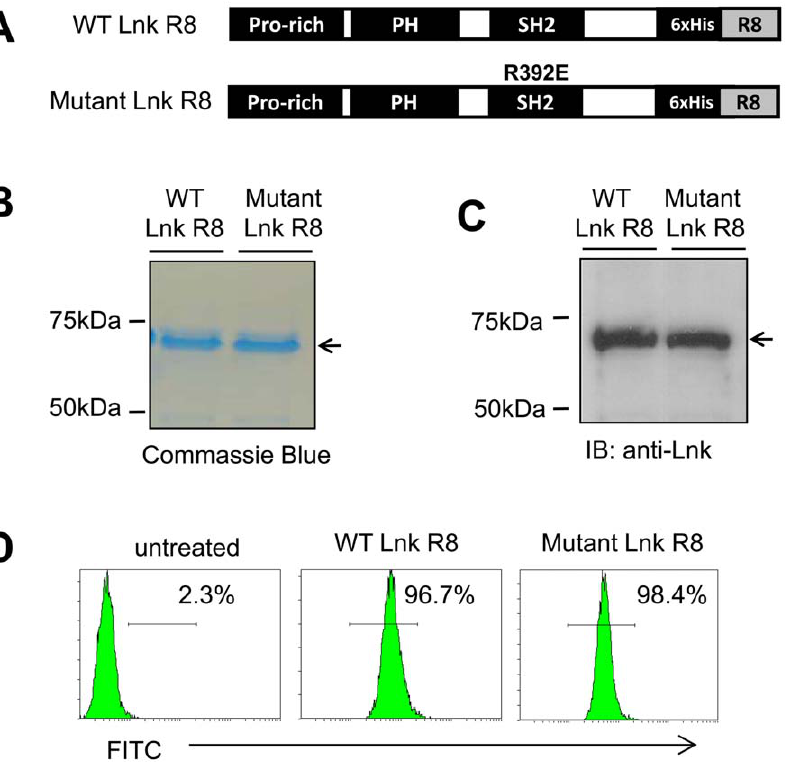
Figure 1. Efficient uptake of WT or mutant Lnk R8 fusion proteins. (A) Diagram of WT or mutant Lnk R8 constructs. Pro-rich:Proline-rich domain, PH:Pleckstrin homology domain, SH2:Src Homology 2 domain. (B) Coomassie blue staining of purified WT Lnk R8 or mutant Lnk R8. (C) Western blotting using anti-Lnk antibody confirmed the 70 kDa bands as WT and mutant Lnk R8. (D) Flow cytometry data showing internalization efficiency of FITC-labeled WT or mutant Lnk R8 in M-MOK cells.